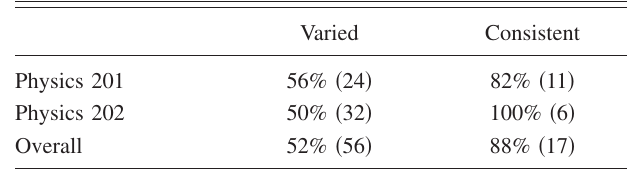
TABLE I. Success rate for students using a variety of problem- solving strategies on different representations of a problem versus students consistently using the same strategy. Numbers in parenthe- ses indicate the number of problems solved by students in a cat- egory. Data are presented for each class and for both classes aver- aged together. The performance difference in the “Overall” category is significant at the p =0.007 level.